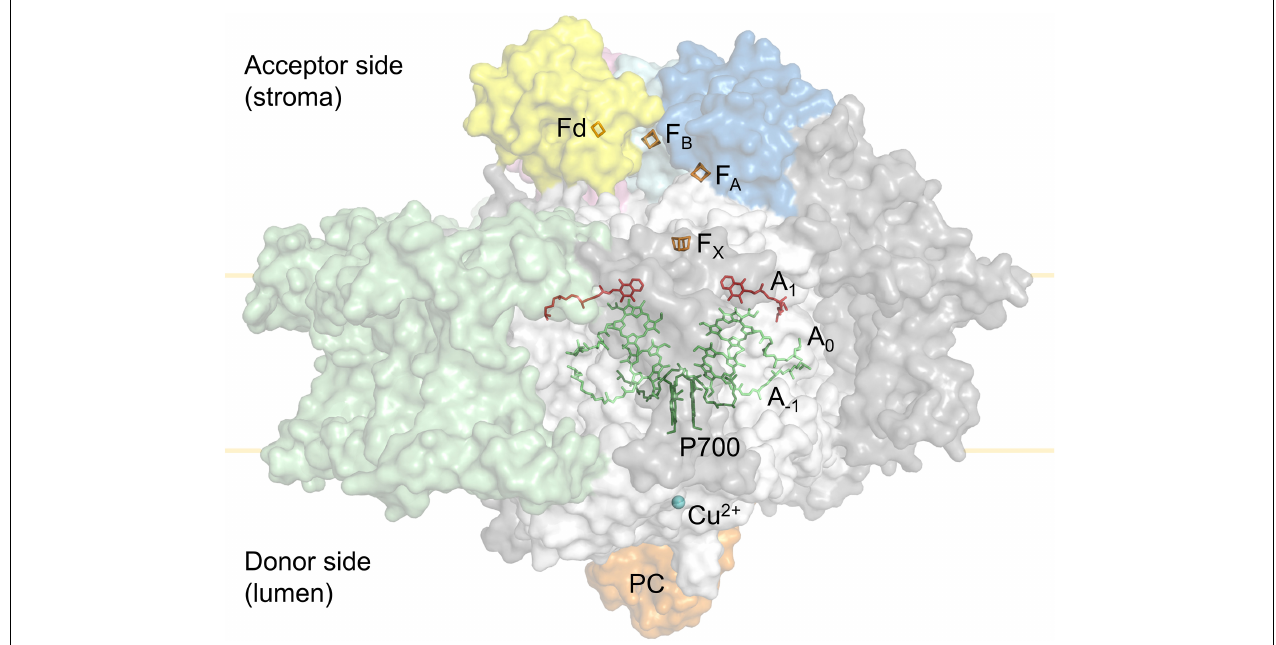
FIGURE 2 | Simplified tertiary structure of the PSI:plastocyanin:ferredoxin complex (PDB accession 6YEZ; Caspy et al., 2020), showing protein subunits PsaA and PsaB (white), PsaC (cyan), PsaD (blue), PsaE (pink) and LHCI subunits (green). Other PSI subunits are coloured grey. Also shown are plastocyanin (orange) at the PSI donor side and ferredoxin (yellow) at the PSI acceptor side. Cofactors involved in electron transport are shown; Cu 2 + (blue), P700 (dark green), A − 1 and A 0 chlorophylls (lime), A 1 phylloquinone (red) in PSI, as well as the PSI 4Fe4S clusters F X , F A , F B (orange) and the ferredoxin (Fd) 2Fe2S cluster